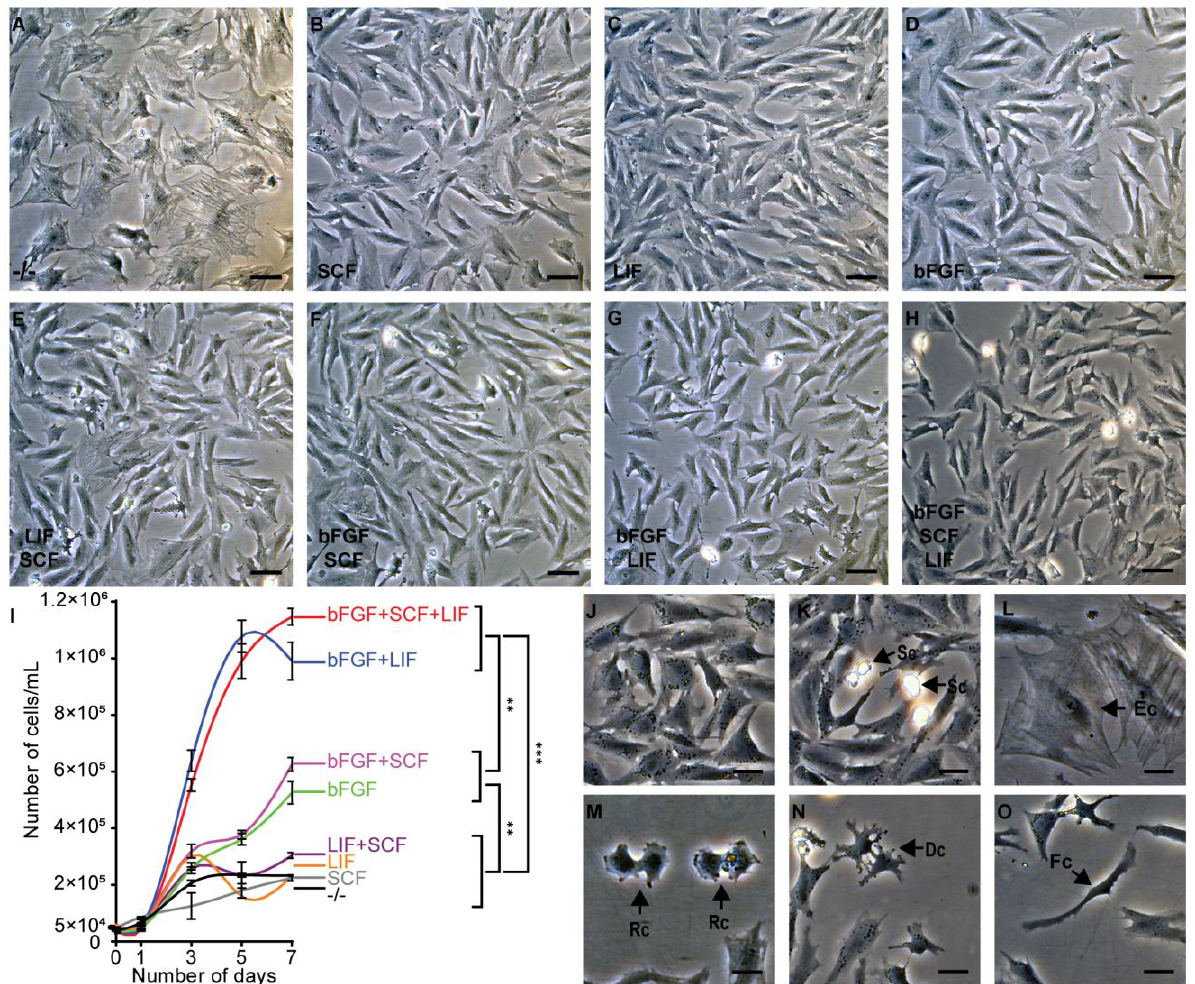
Figure 3. Effect of different cytokine combinations on the morphology and growth rate of GPT cells during 7 days of culture. ( A ) All GPT cells differentiated into large epithelial-like cells in medium without bFGF, LIF, and SCF (-/-). ( B , C , E , F ) GPT cells generated many epithelial-like cells under the condition of 4 combinations LIF, SCF, LIF and SCF, and SCF and bFGF. ( D ) GPT cells consisted of epithelial-like cells and polygonal-like cells in the presence of bFGF. ( G ) GPT cells consisted of most polygonal-like cells and a few epithelial-like cells in the presence of LIF and bFGF. ( H ) Compared with the bFGF and LIF combinations, the bFGF, LIF, and SCF group had no obvious effect on cell morphology. ( I ) Growth curve of GPT cells under different cytokine combinations. Cell number was shown as the mean ± SEM of three samples and the values with asterisks were significantly different (** p < 0.01, and *** p < 0.001). Statistical analysis was performed by one-way ANOVA and Student’s t -test. ( J ) Most GPT cells treated with bFGF and LIF showed a polygonal-like cell shape about 20 µ m in diameter. ( K – O ) GPT cells generated a few cells with diverse morphology (Arrows) in the coexistence of LIF and bFGF. Sc, spherical cells (different sizes); Ec, Epithelial-like cells; Rc, Round cells (under a state of cell division); Dc, Dendritic-like cells; Fc, Fibroblast-like cells. Scale Bars: 50 µ m in ( A – H ); 20 µ m in ( J – O